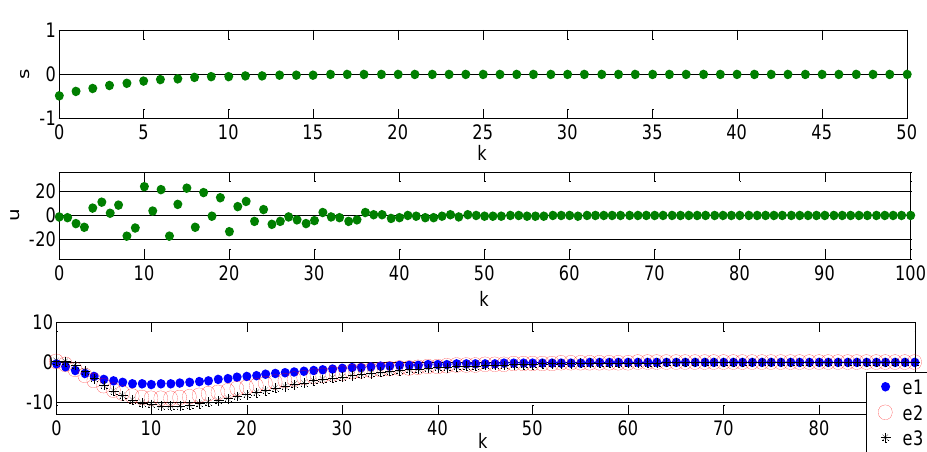
Figure 5. Responses of the switching surface, control input and synchronization error.